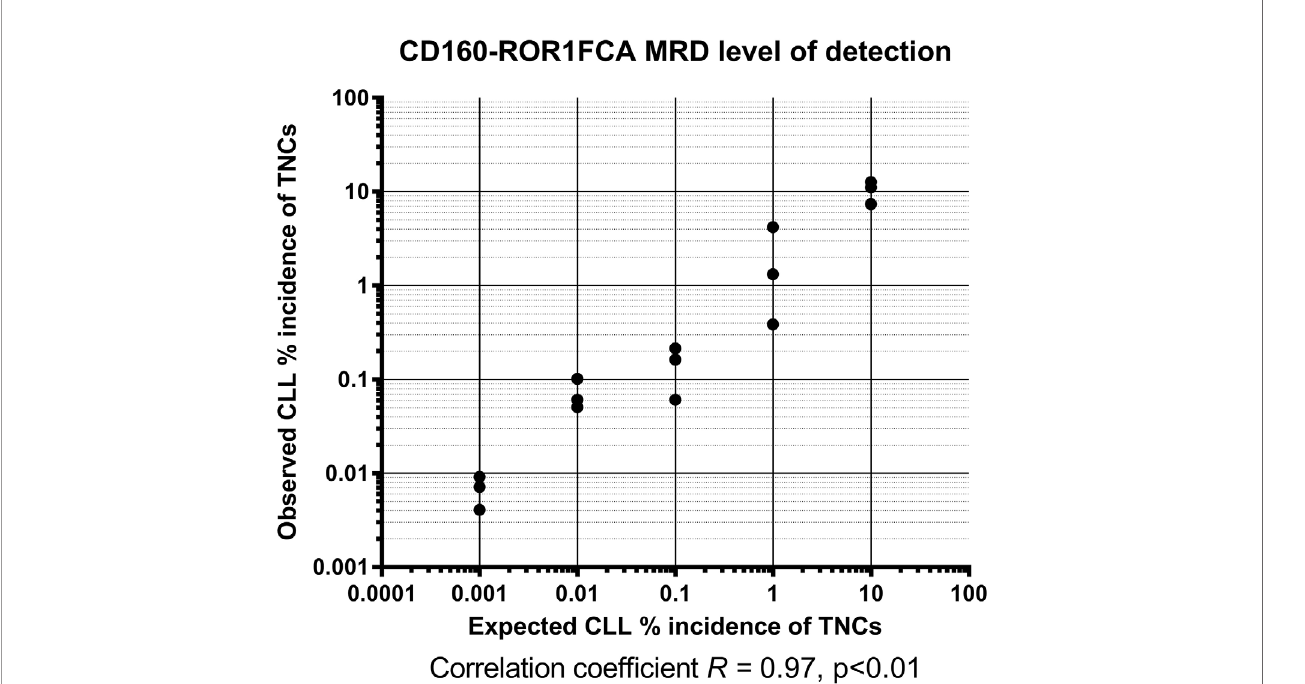
FIGURE 1 | CD160-ROR1FCA MRD level of detection. Samples from three patients with CLL were serially diluted in normal leukocytes, such that the CLL cells represented an actual tumor burden as low as 0.001% of the total nucleated cell population. The observed MRD detection with CD160-ROR1FCA showed excellent concordance with the theoretical MRD level: limit of detection 0.001%, with a limit of reportable quanti fi cation of 0.003% ( Figure 1 , R 2 = 0.978, p <